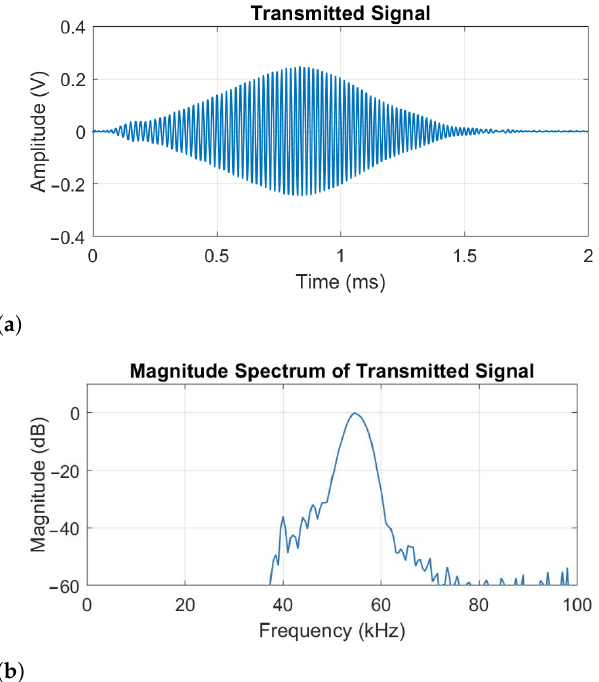
Figure 5. Plots showing ( a ) the ultrasonic chirp transmit signal as recorded by a calibrated mi- crophone (GRAS 46BF-1 1/4 inch), and ( b ) its corresponding frequency domain representation. The small peak seen at 40 kHz is a result of ringing at the transducers’ fundamental frequency.